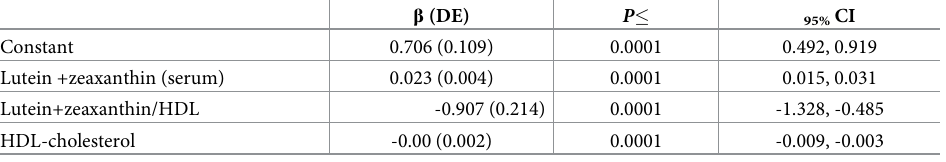
Table 3. Multivariate regression analysis of biochemical and dietary factors and gender data (n = 145) associated with MPOD (n = 290).